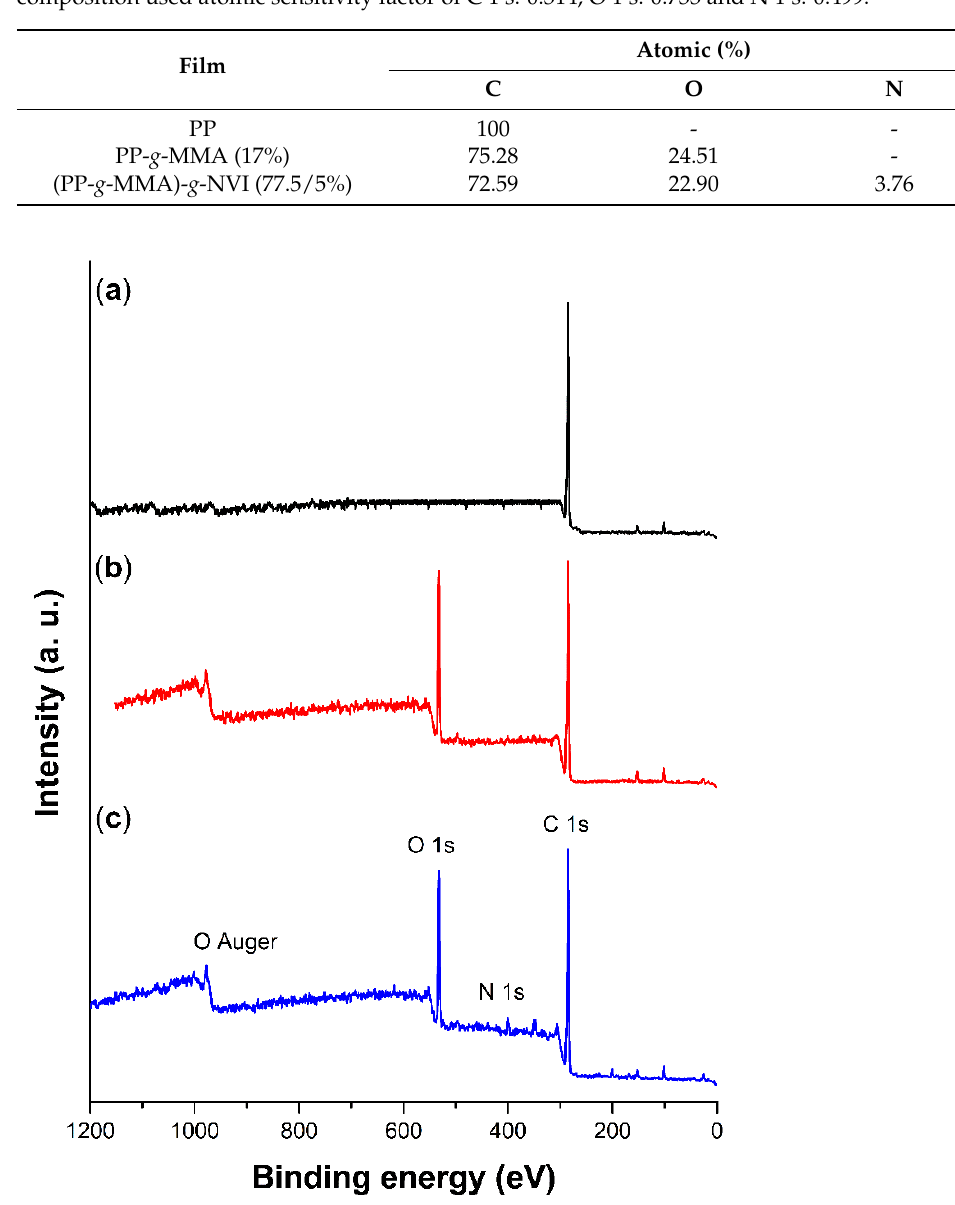
Table 1. XPS results of pristine PP, PP- g -MMA (17%), and (PP- g -MMA)- g -NVI (77.5/5%): elemental